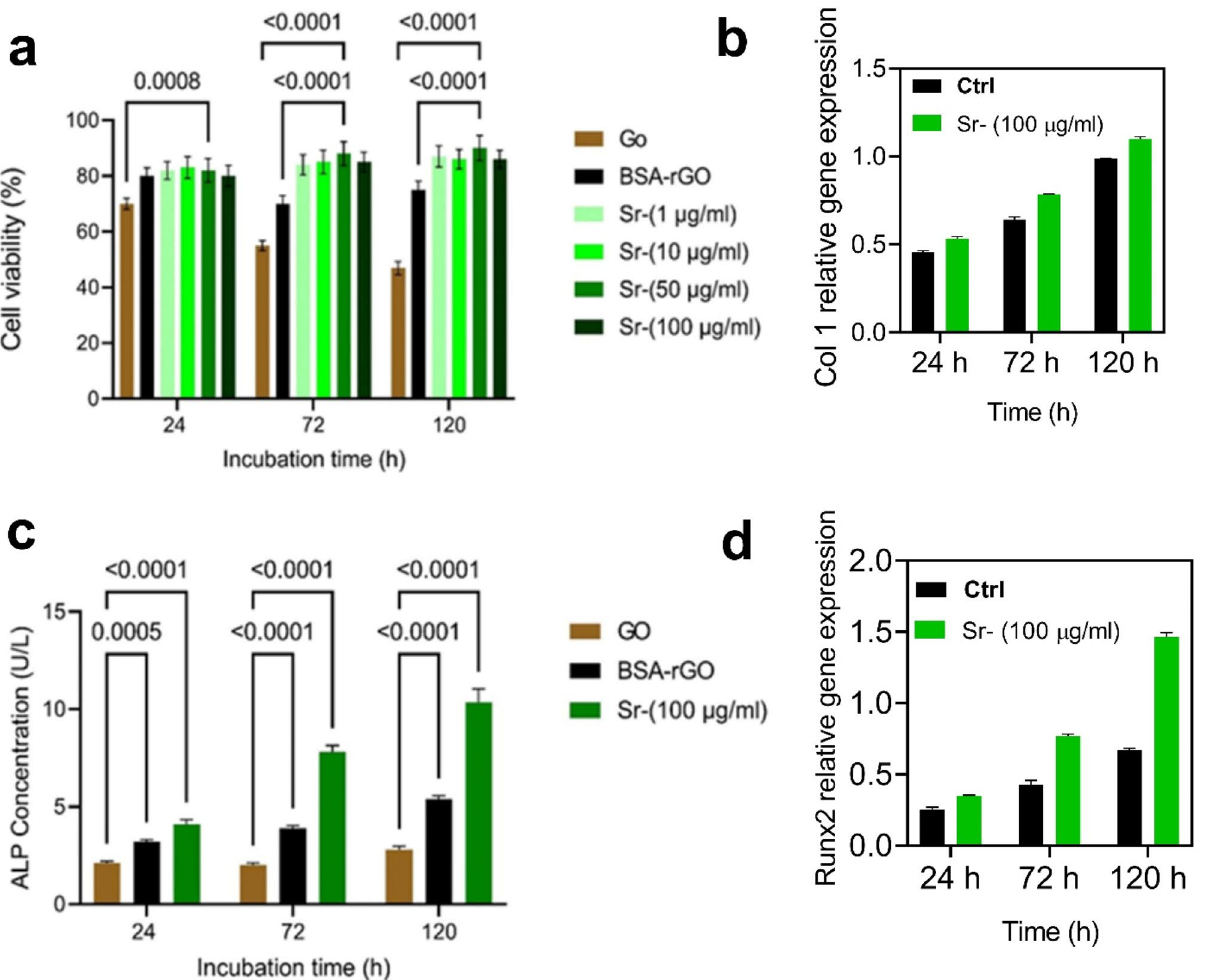
Figure 8. Biological assessment of the synthesized nanosheets. ( a ) Cell viability measurement (MTT assay) of MC3T3-E1 cells treated with different concentrations of the Sr-BSA-rGO (1, 10, 50, 100 μg/ml) and a constant concentration of GO and BSA-rGO (100 μg/ml) at various incubation times (24, 72 and 120 h). ( b ) ALP activity measurement of the MC3T3-E1 cells treated with a constant concentration of GO, BSA-rGO and Sr-BSA-rGO nanosheets (100 μg/ml) at different incubation times (24, 72 and 120 h). All experiments were conducted in triplicate (n = 3). ( c ) Effect of Sr-BSA-rGO on osteogenic differentiation of MC3T3-E1 cells. Sr-BSA-rGO nanosheets were used to treat the MC3T3-E1 cells in 100 g/ml. ( d ) Following an incubation period of 24, 72 and 120 h, RT-PCR was used to detect RUNX2 and Col 1A1 expression levels, and their normalization was done against